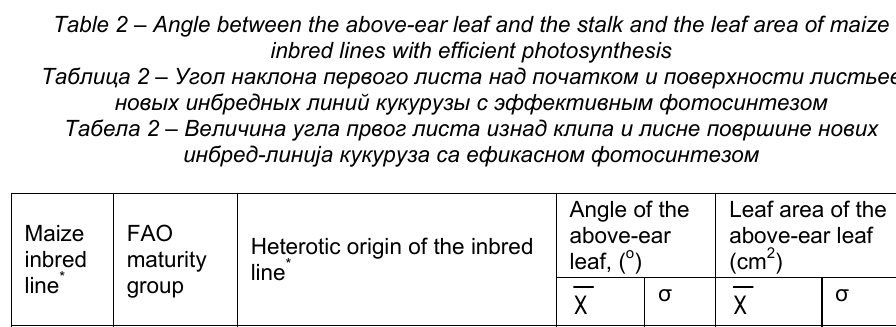
Table 2 – Angle between the above-ear leaf and the stalk and the leaf area of maize inbred lines with efficient